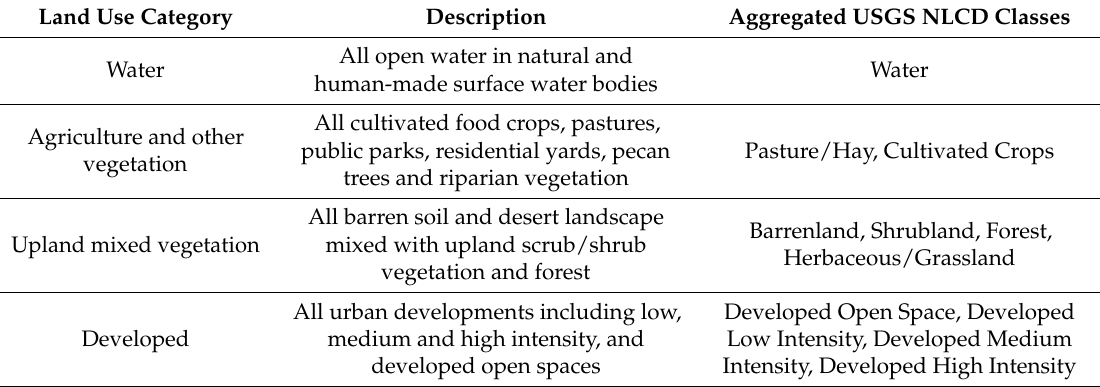
Table 1. Definition of land use categories used in the study.